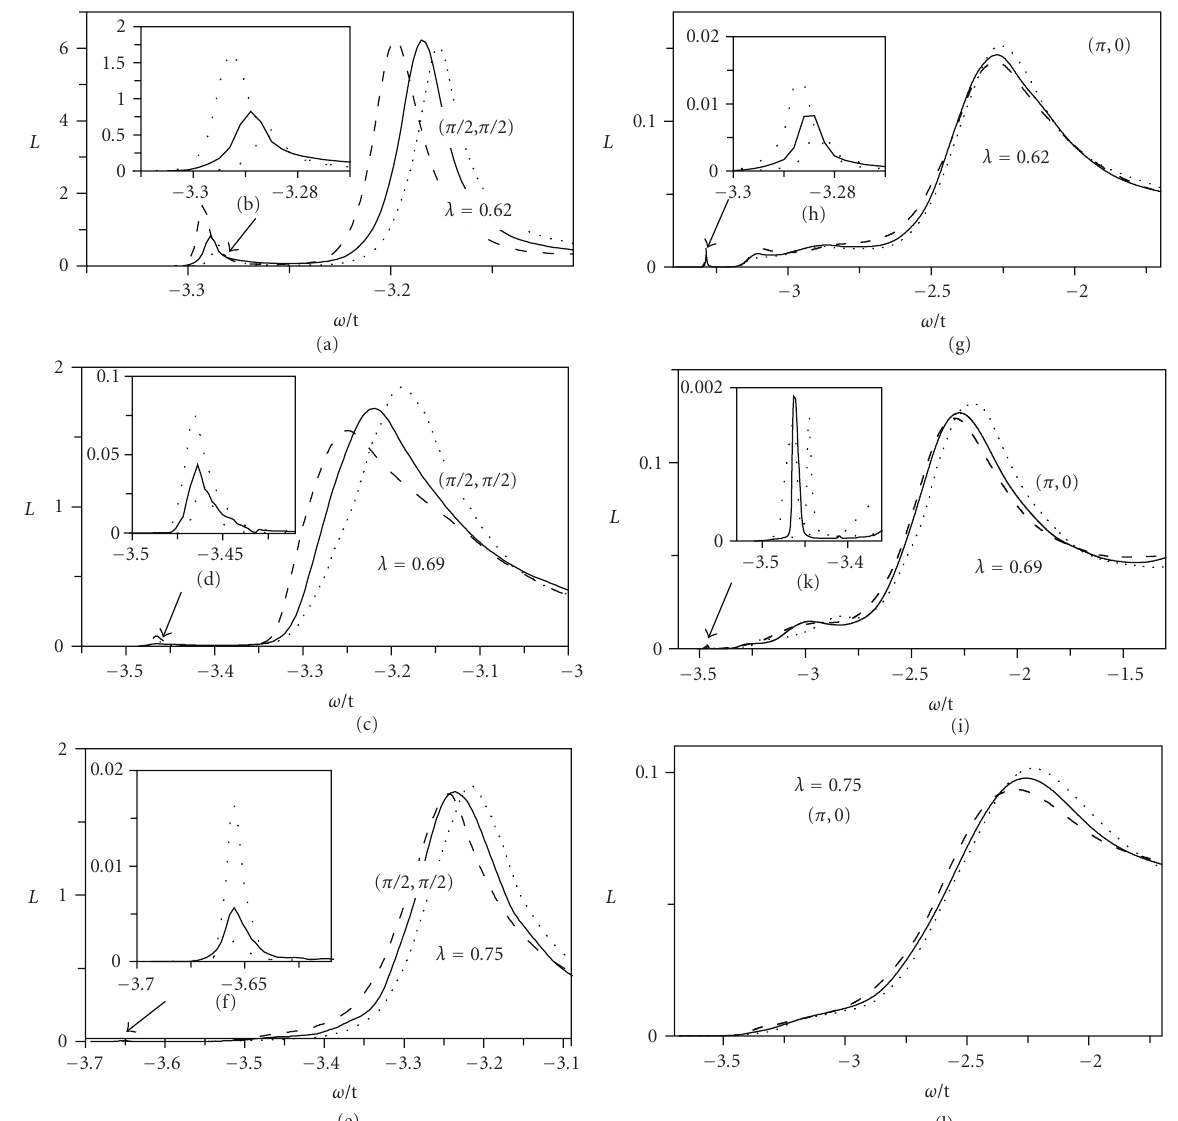
Figure 7: Low-energy part of the spectral function. Spectra of normal, isotope substituted, and “anti-isotope” substituted compounds are drawn by solid, dotted, and dashed lines, respectively. (a), (c), (e) and (g), (i), (l) correspond to nodal ( π/ 2, π/ 2) and antinodal ( π ,0) points. Insets (b), (d), (f), (h), and (k) show the peak corresponding to real